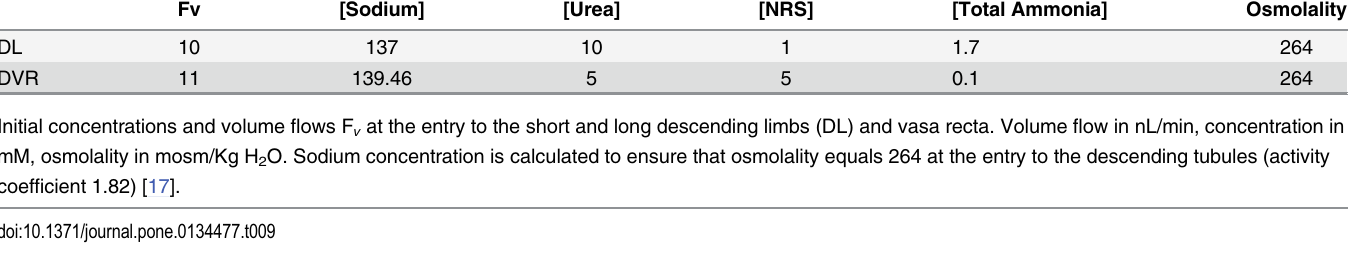
Table 9. Inflow to the entry to the tubes. Fv Initial concentrations and volume fl ows F v at the entry to the short and long descending limbs (DL) and vasa recta. Volume fl ow in nL/min, concentration in mM, osmolality in mosm/Kg H 2 O. Sodium concentration is calculated to ensure that osmolality equals 264 at the entry to the descending tubules (activity coef fi cient 1.82)